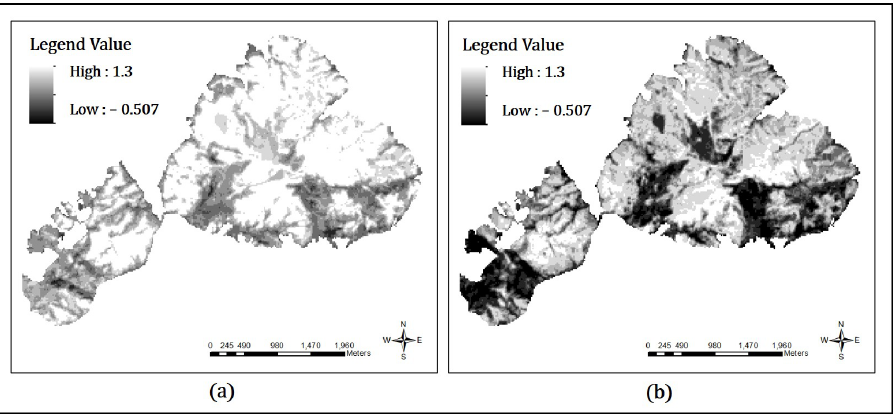
Figure 5. Difference in NBR; based on the fire severity level’s legend: ( a ) pre-fire vs. immediately after the fire and ( b ) pre-fire vs. four months later.